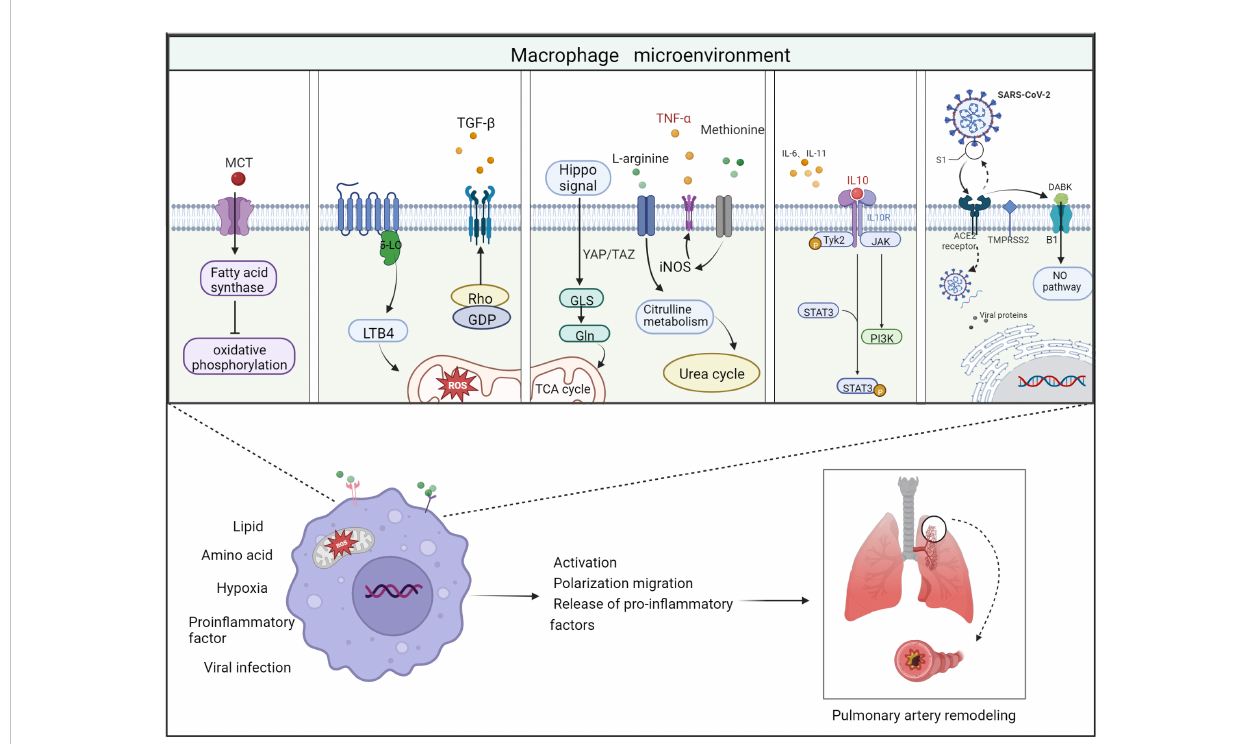
FIGURE 3 Schematic diagram of the 5 important factors affecting the macrophage microenvironment. Lipid metabolism: monocrotaline induces an increase in body fatty acids and a decrease in fatty acid oxidation. Hypoxic environment: 5-lipoxygenase (5-LO) activation metabolizes leukotriene B4 (LTB4) to exacerbate ROS toxicity in mitochondria; Rho kinase signaling pathway activates TGF- b and causes vasoconstriction. Amino acid metabolism: two related transcriptional co-activators of Hippo signaling pathway, YAP/TAZ, can activate GLS enzymes and promote glutamine metabolism and TCA cycle disorder; arginine can generate citrulline in response to iNOS to participate in urea cycle and promote smooth muscle cell proliferation; methionine can induce elevated iNOS activity and increased TNF- a release, thus causing macrophages to M1 direction of polarization. Pro- in fl ammatory and anti-in fl ammatory factors: In fl ammatory factors and chemokines secreted by immune cells are involved in the regulation of their respective in fl ammatory pathways, thus promoting or suppressing the in fl ammatory response. For example, IL-10 activates JAK1 and TYK2 phosphorylation and thereby activates the STAT3 pathway. Viral infection: Angiotensin-converting enzyme-2 (ACE2) receptor mediates the entry of SARS-CoV-2 virus via transmembrane protease serine 2 (TMPRSS2). On the one hand, the increase in free DABK content in the presence of decreased ACE2 function activates B1 receptors and also induces NO pathways to trigger in fl ammation; on the other hand, the virus attacks the body ’ s immune function through DNA replication, thus aggravating the body ’ s immune de fi ciency. Thus, these factors affecting the macrophage microenvironment can worsen the PAH process when they are